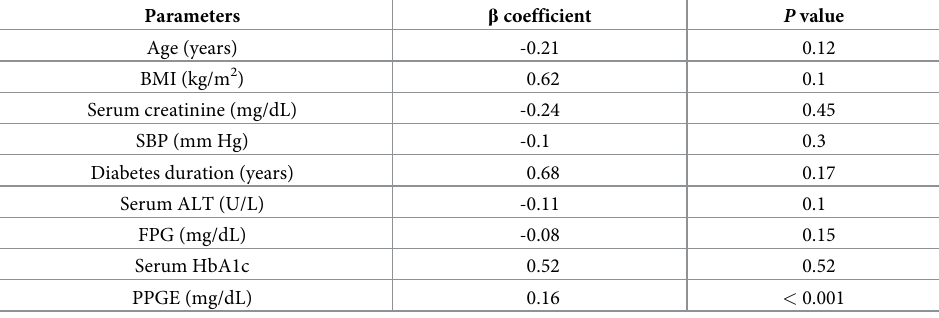
Table 2. Linear regression analysis of parameters associated with plasma low-density lipoprotein cholesterol concentration.